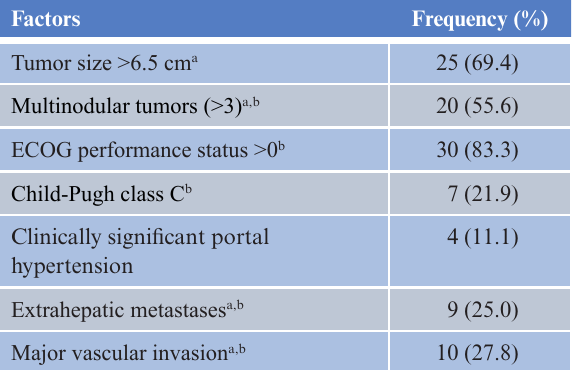
Table 3: Inoperable